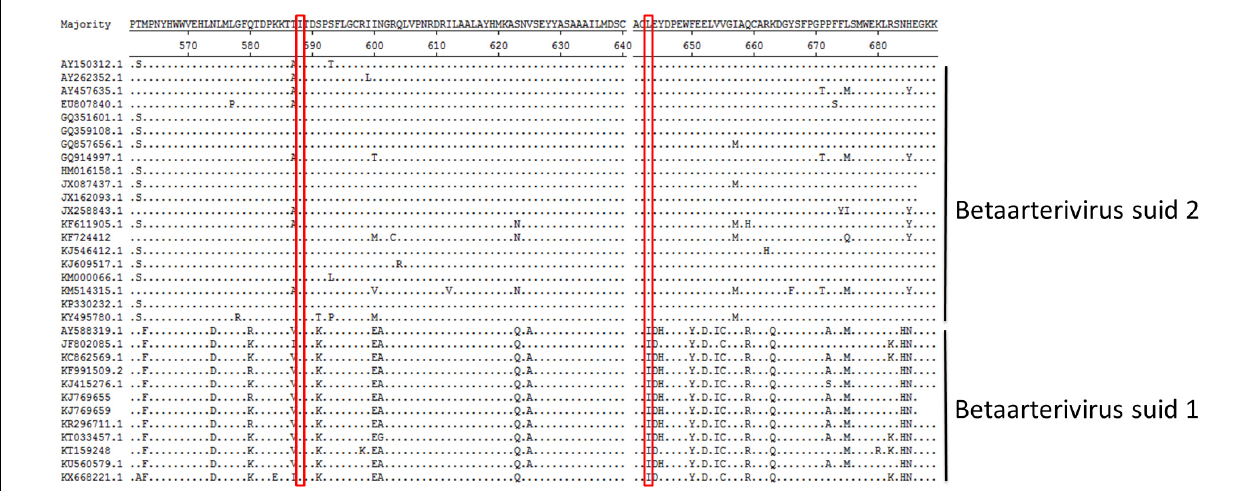
FIGURE 9 | The sequence alignment of aa residues 561-689 in PRRSV Nsp9. The sequences of Nsp9 from the 32 PRRSV strains were pulled from Genbank and then analyzed using Lasergene. The residues at 588 and 643 of Nsp9 are shown in red frame with dots indicating identical amino acid